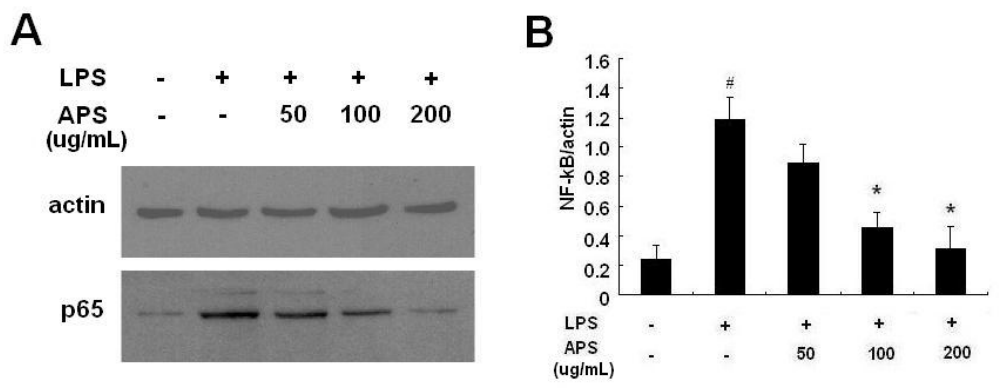
Figure 4. APS inhibited LPS-induced NF- κ B expression in THP-1 cells. THP-1 cells were treated with LPS (1 μ g/mL) and different concentration of APS (0, 50, 100 and 200 μ